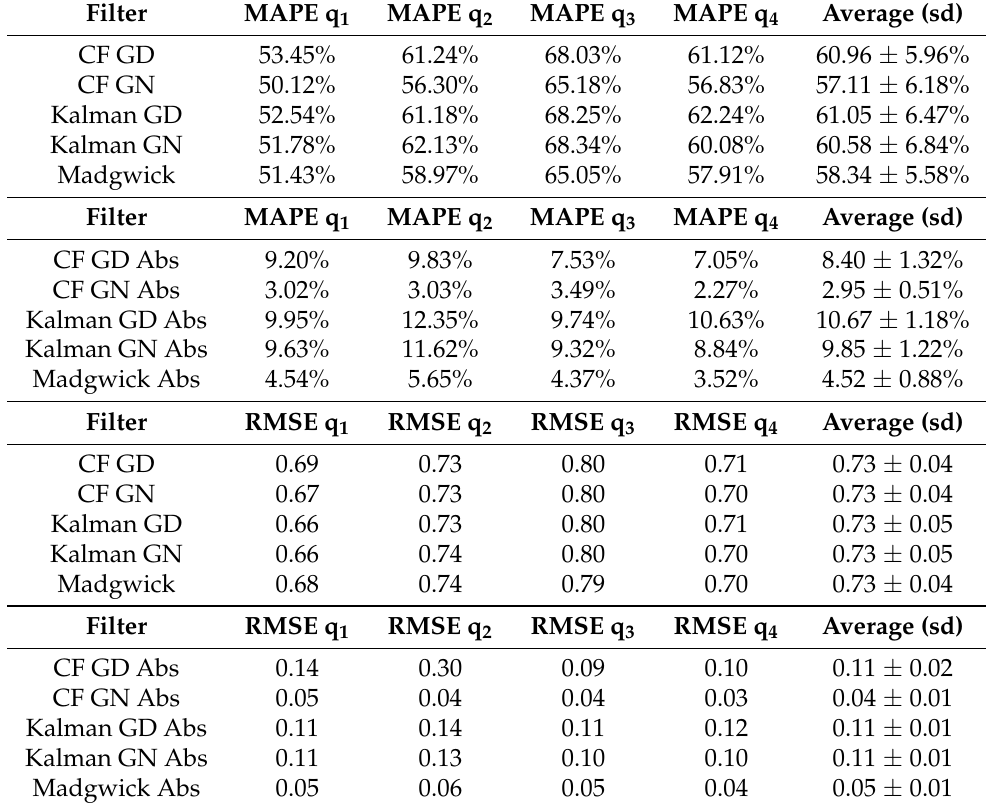
Table 4. Experiment 3—Metrics.